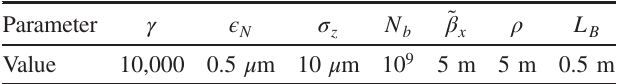
TABLE I. Parameters for the last bend in the second bunch compressor of Linac Coherent Light